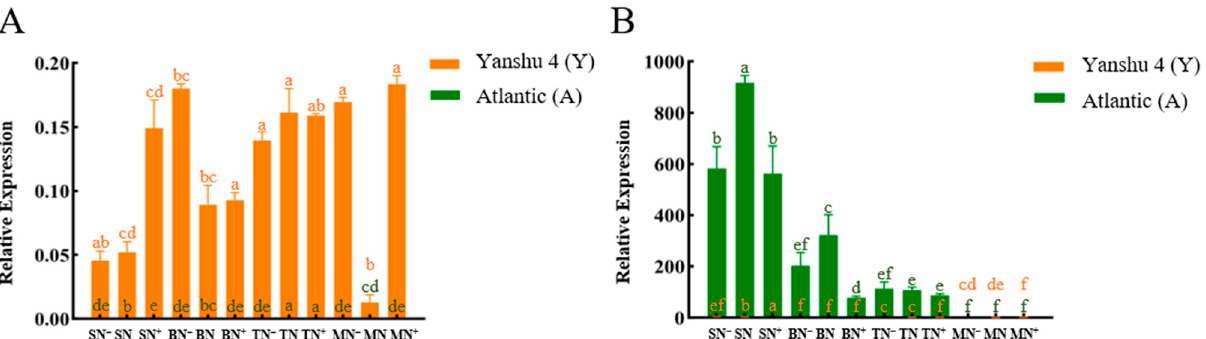
Figure 5. Relative expression of glutamine synthase gene StGS1-2 in two genotypes of potato under different N supply levels. ( A ) Leaf (L); ( B ) Root (R). S, B, T, and M represent seedling stage, budding stage, tuber expansion stage, and mature stage, respectively. N − , N, N + are different N supply levels, representing low N, normal N, and excess N, respectively. Different letters indicate the difference of relative gene expression in different periods under different N application levels ( p < 0.05).